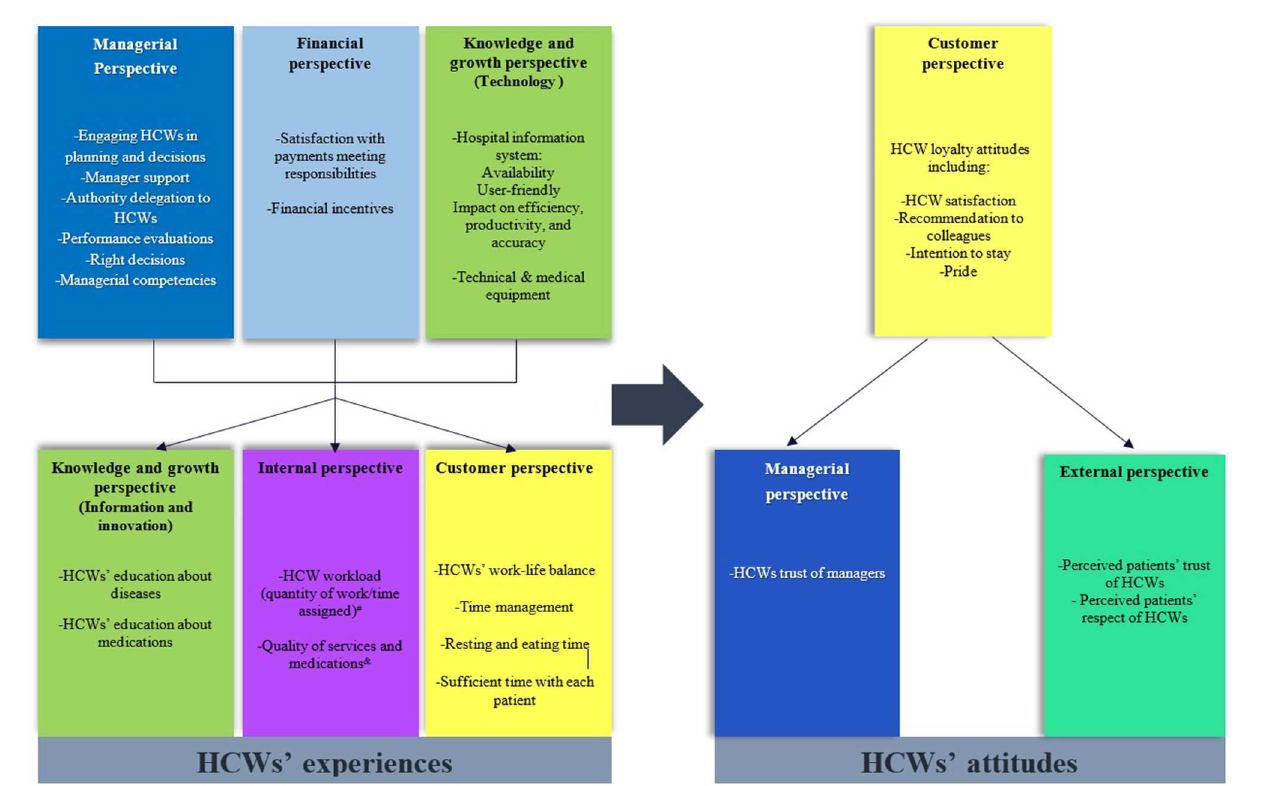
FIGURE4 The theoretical framework for the impact of HCWs’ experiences on their attitudes based on BSC perspectives (source: own elaboration). # Workload loaded with work-life balance in customer perspective items in the workload time-life balance (WTLB) factor; & Loaded with knowledge and growth items in the quality and development initiatives (QUALDEV)